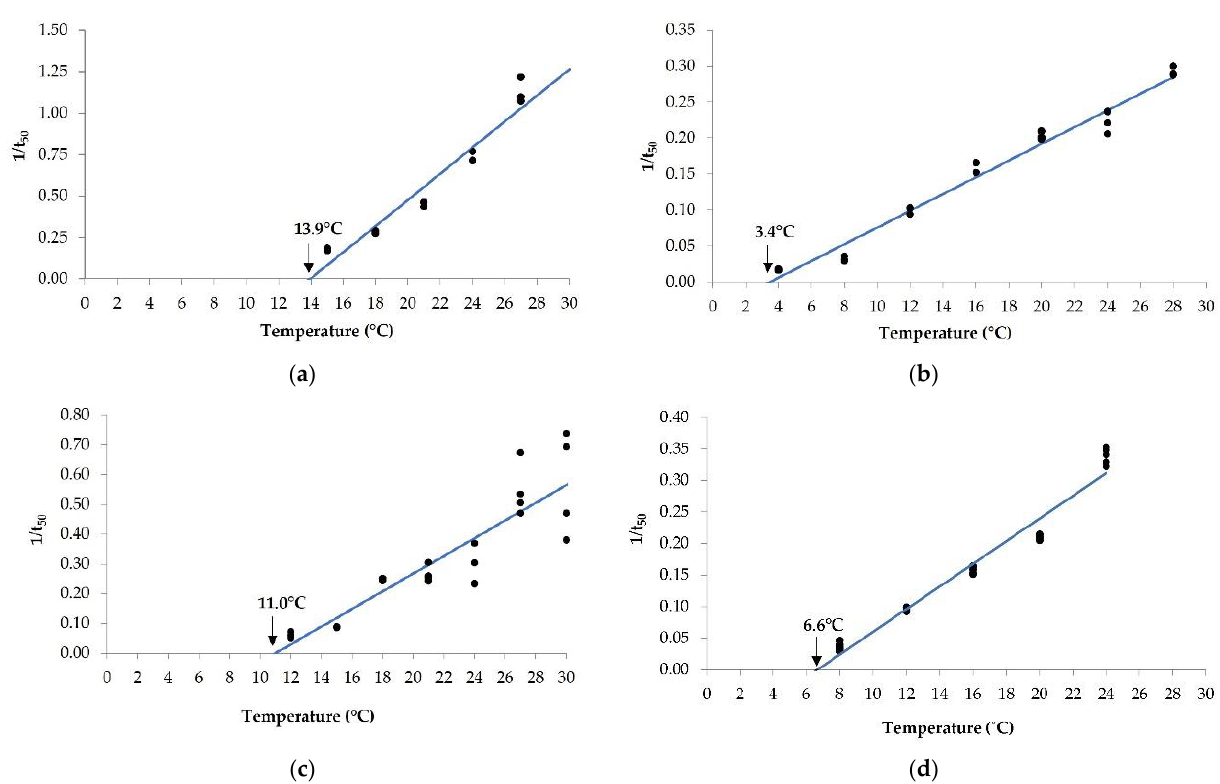
Figure 3. Estimated base temperatures. The solid line represents the linear regression line and the points represents the inverse value of the time necessary to reach 50% of germination (1/t 50 ).The estimated value of the base temperature is the intersection of the regression line with the x -axis: ( a ) Amaranthus retroflexus (T b = 13.9 ± 0.36 ◦ C; y = 0.079x − 1.010; r 2 = 0.96); ( b ) Chenopodium album (T b = 3.4 ± 0.36 ◦ C; y = 0.012x − 0.04, r 2 = 0.98); ( c ) Panicum capillare (T b = 11.0 ± 1.99 ◦ C; y = 0.030x − 0.328; r 2 = 0.82); ( d ) Setaria pumila (T b = 6.6 ± 0.09 ◦ C; y = 0.018x − 0.119; r 2 =